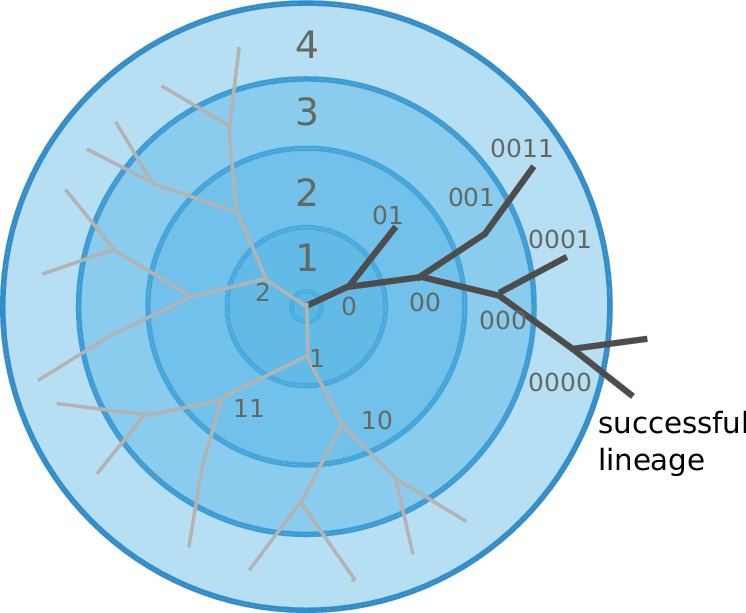
Viral populations escape adaptive immunity by accumulating antigenic mutations.Via cross-reactivity, the immunity foot-print of ancestral variants (center of the graph) mediates competition between related emerging viral strains and can drive all but one of the competing lineages extinct. At high mutation rates and relatively short range of antigenic cross-reactivity, different viral lineages can escape inhibition and continue to evolve independently.